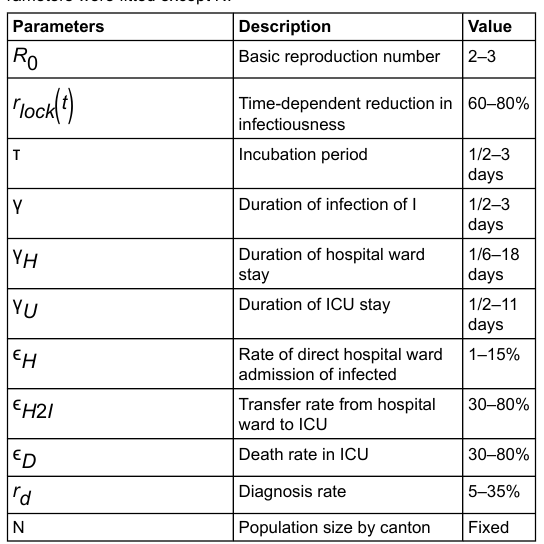
Table 3: Parameters, descriptions and values in the BT model. All pa- rameters were fitted except